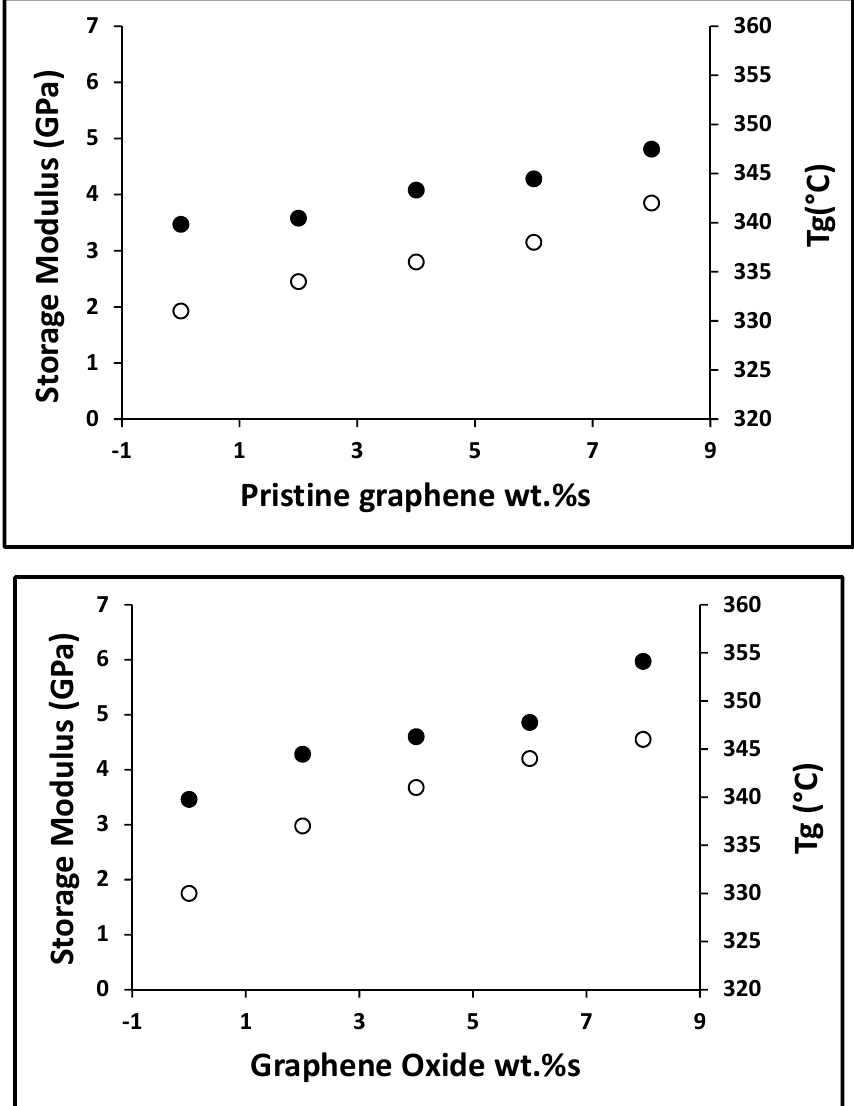
Figure 8. Variation of Glass transition Temperature (Tg) ( ο ) and the Storage Modulus ( ● ) with Graphene contents in ArGr(upper) and ArGrO(lower) Composites.